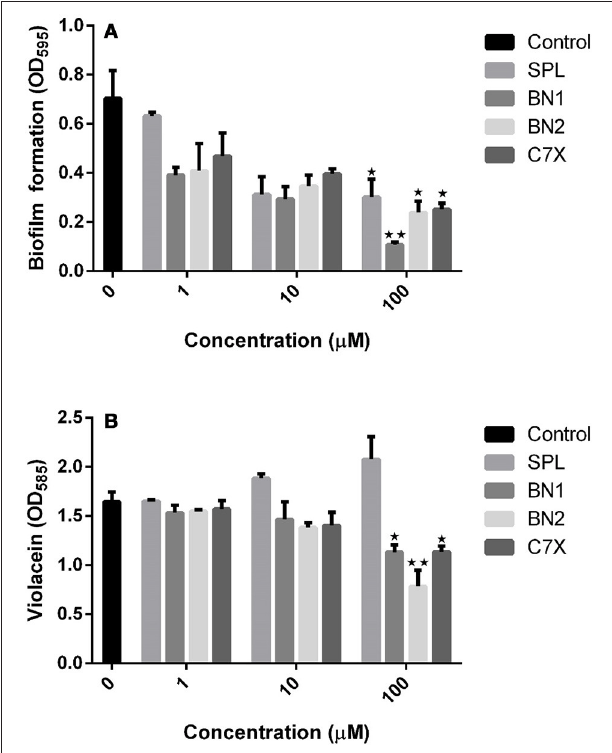
FIGURE 4 | The effect of QSI on biofilm formation and violacein. (A) The biofilm formation was inhibited by QSIs. Especially, BN2 and C7X have reduced the biofilm formation significantly whereas BN1 decreased the biofilm formation drastically ( ∼ 50%). (B) The similar trend was followed in violacein production also. Though all the three QSIs reduce the violacein production, the SPL found be increased. * P < 0.05 and ** P <